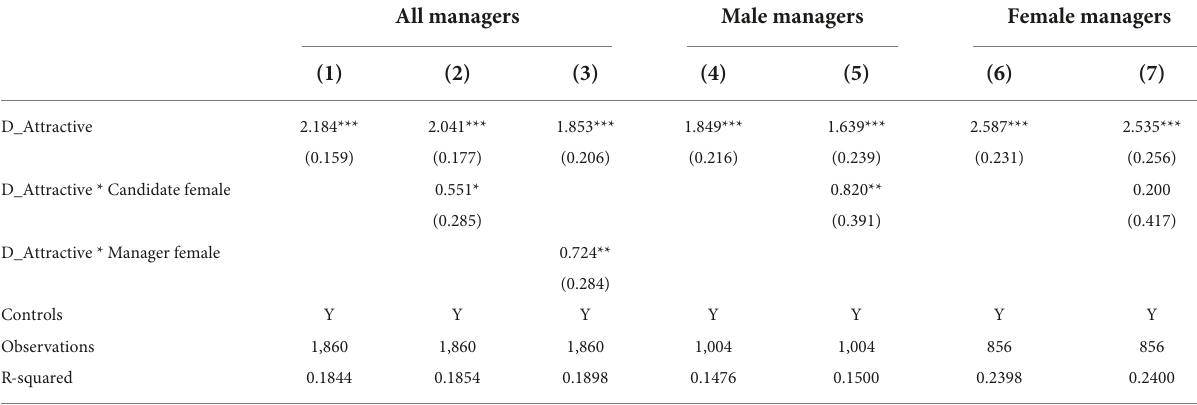
TABLE 4 The effect of dichotomous attractiveness on the tendency to hire a